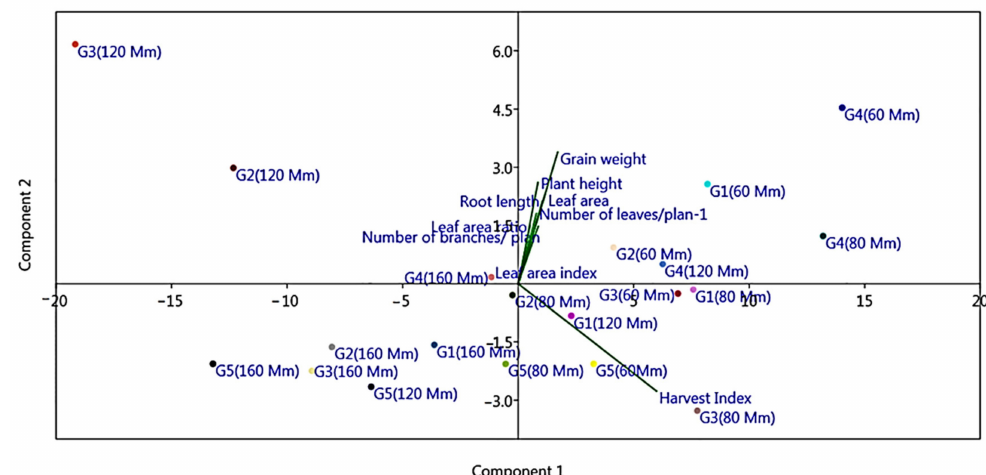
Figure 4. Principal component analysis (PCA) of the quantitative morphological traits for the studied treated quinoa genotypes. The first component demonstrated variance of 91.228% and the second component demonstrated variance of 6.877%; G1: M-28; G2: Q-37; G3: S-10; G4: Regeolone-3; G5: LINE-6.